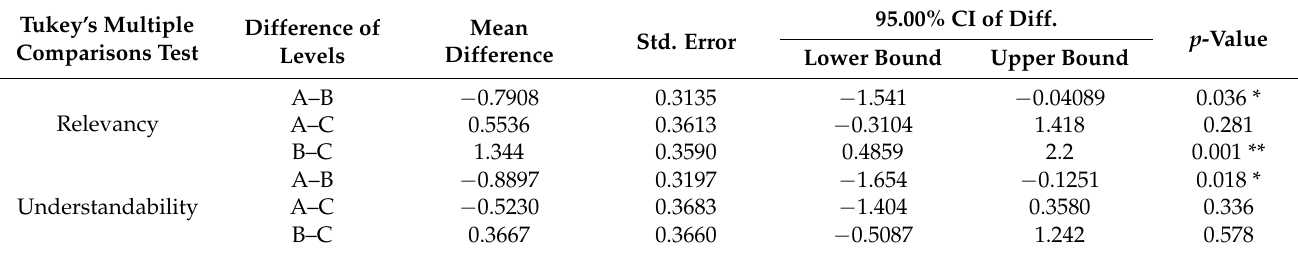
Table 7. Post-hoc test of differences in relevancy and understandability between knowledge